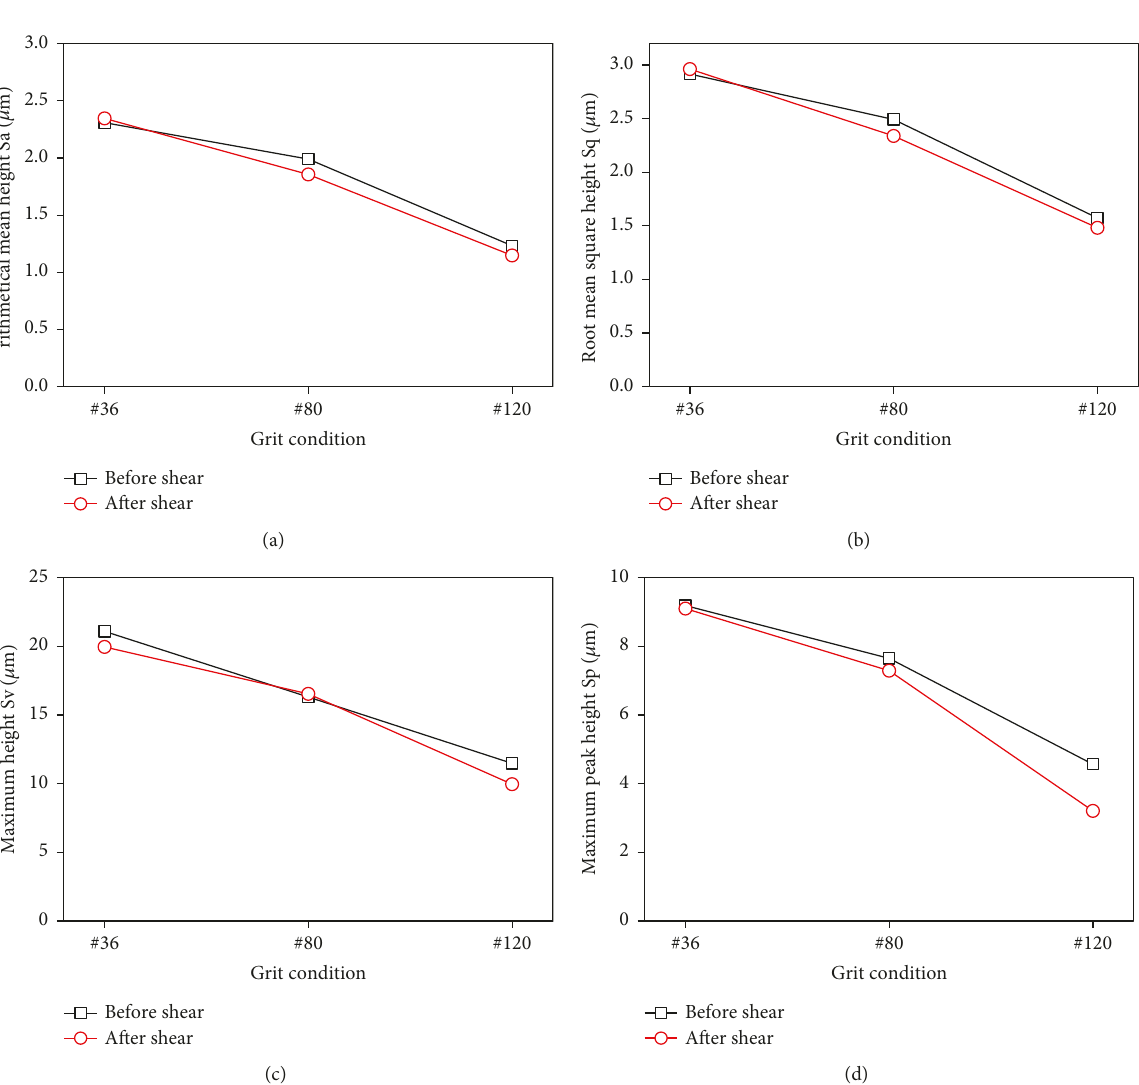
Figure 7: Surface parameters of unsheared and sheared sandstone fractures: (a) arithmetical mean height Sa ; (b) root mean square height Sq ; (c) maximum pit height Sv ; (d) maximum peak height Sp